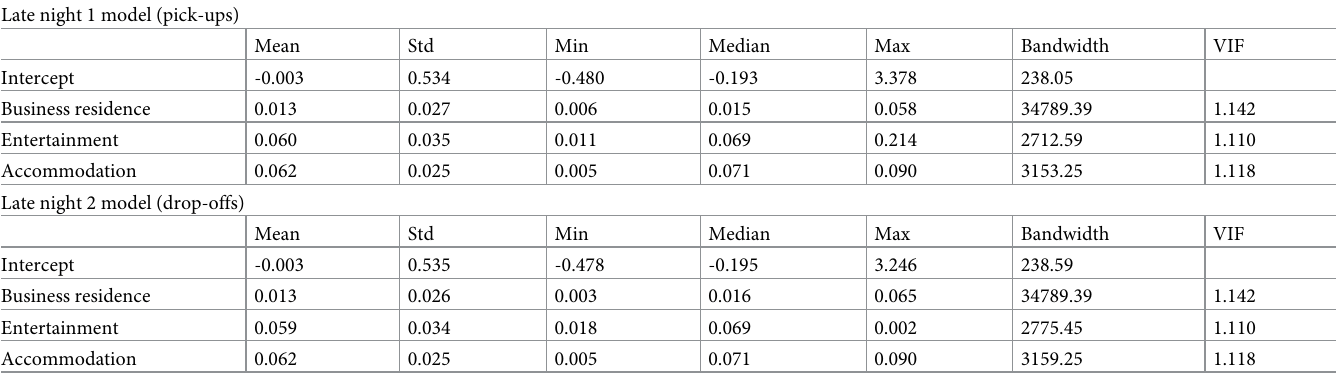
Table 5. Pick-ups and drop-offs during the late